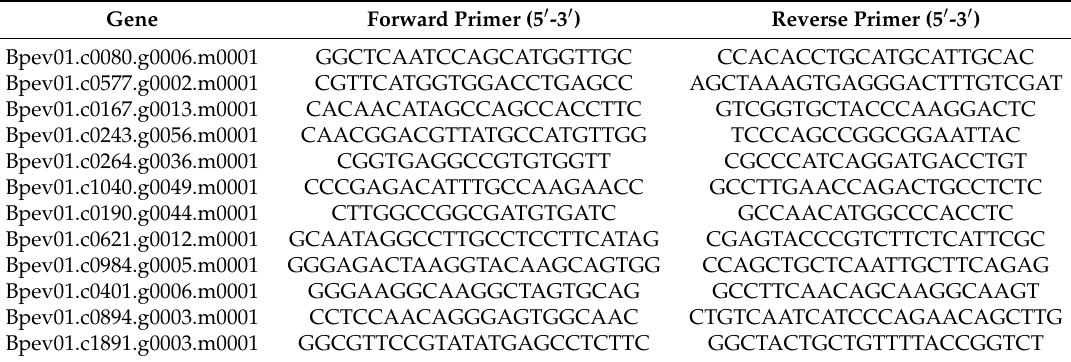
Table 1. The primer sequences used in